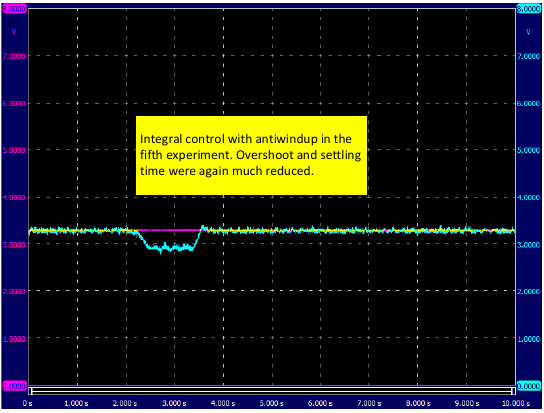
Fig. 11. Tachometer signal in the fifth